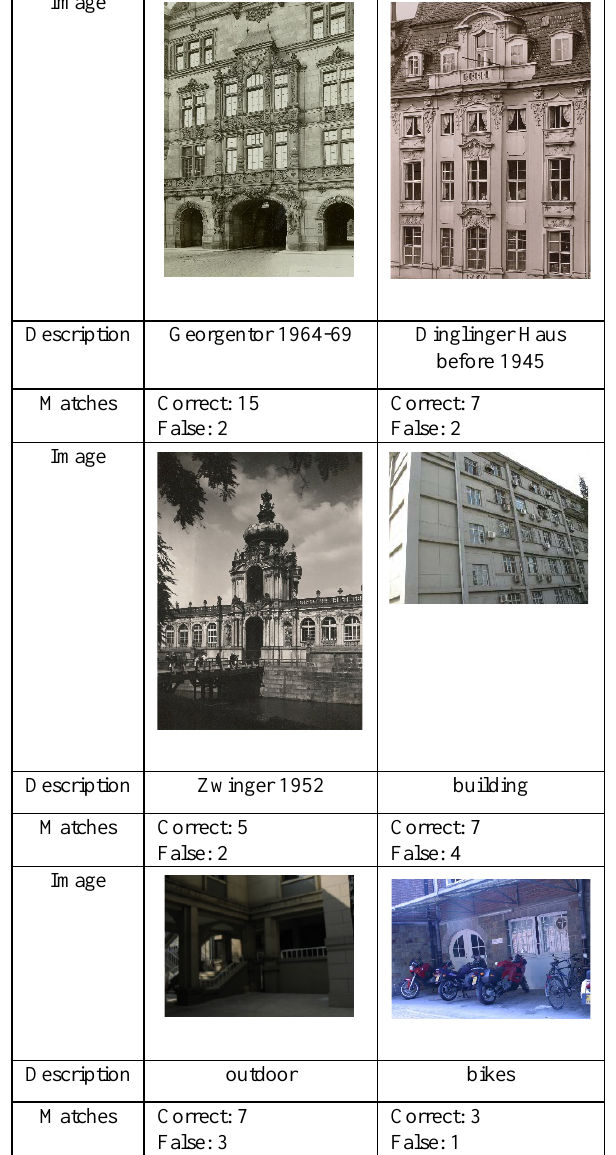
Table 1. Number of correct and false matches using the presented descriptor on different historical